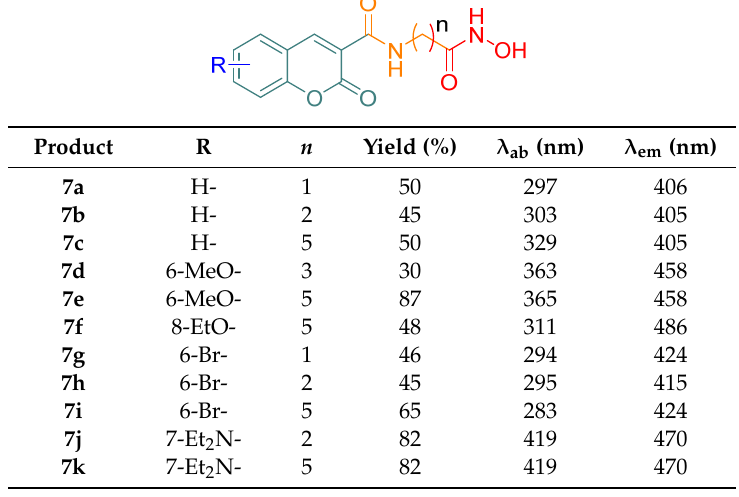
Molecules 2020 , 25 , x FOR PEER REVIEW Table 1. Results of the synthesis of coumarins 7a – k as well as data on absorption and emission.